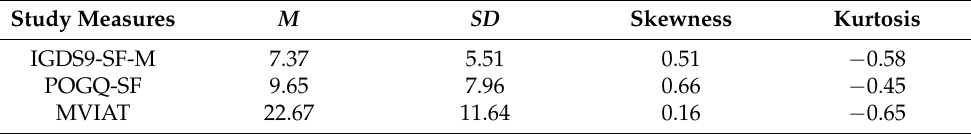
Table 1. Descriptive statistics.